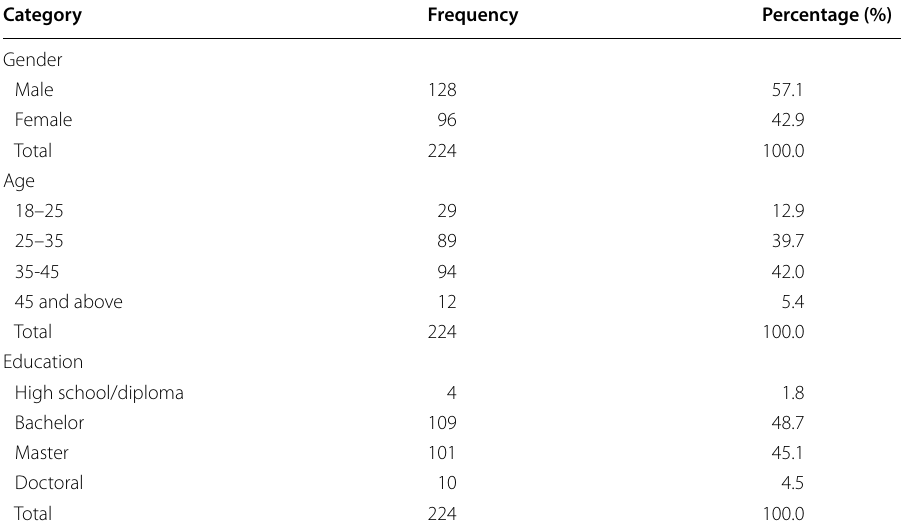
Table 2 Demographical information of